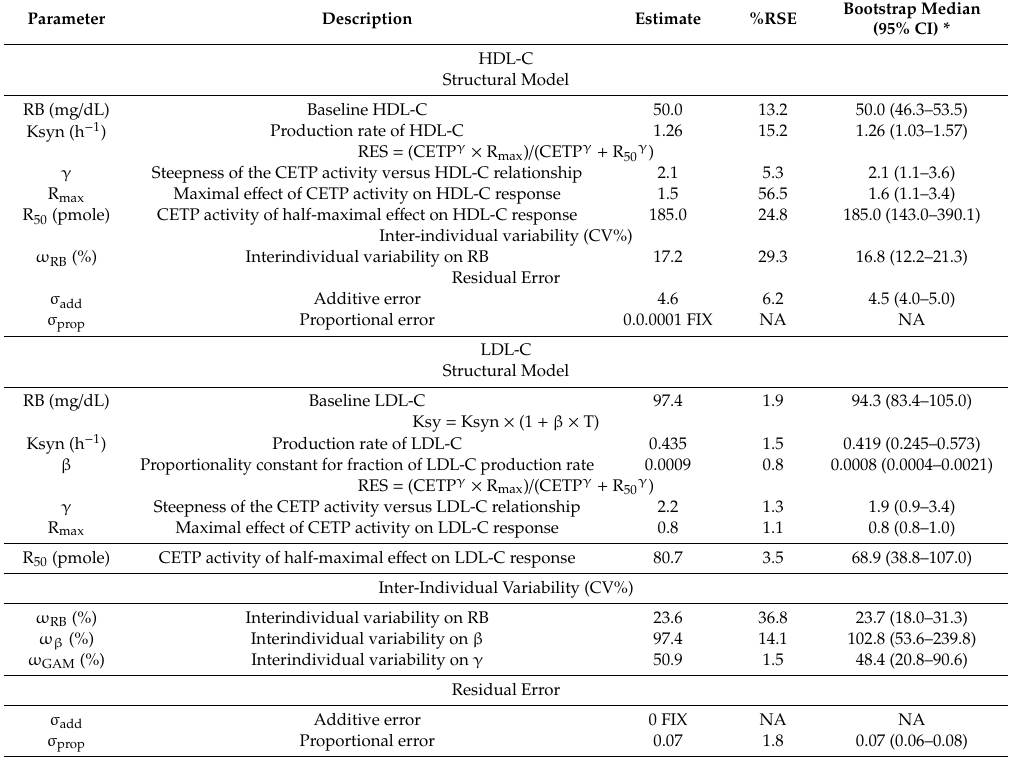
Table 4. Parameter estimates for HDL-C and LDL-C